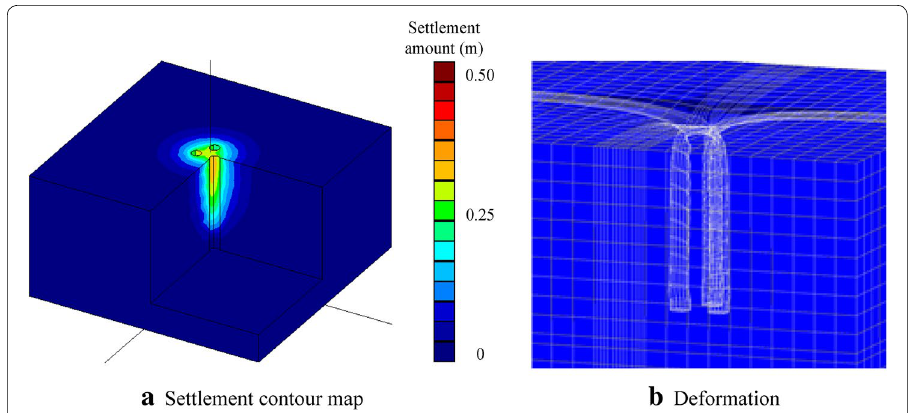
Fig. 4 Deformation behavior of surrounding ground when three pullout holes are hollow. a Settlement contour map. b